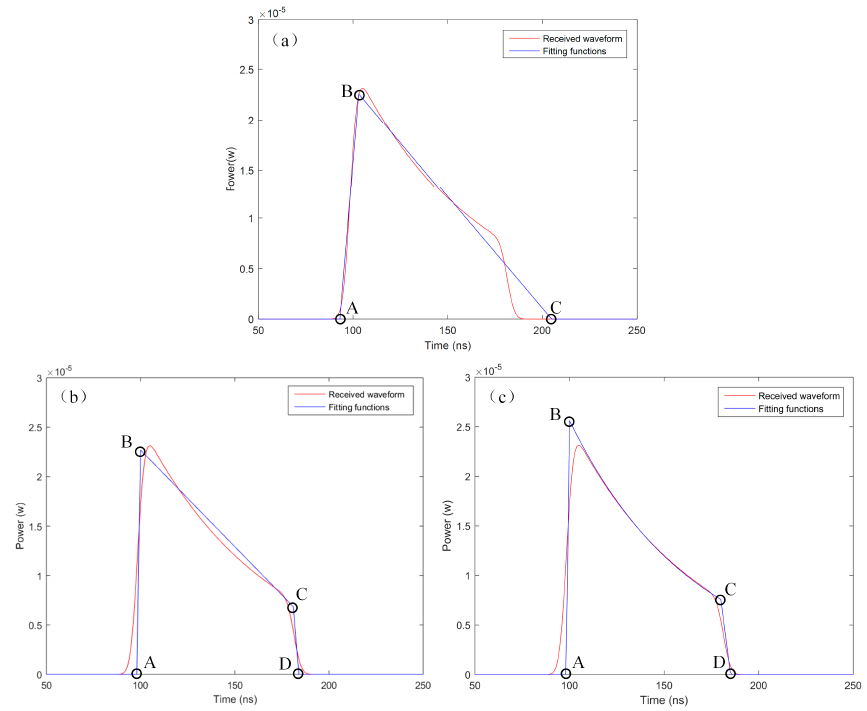
Figure 2. Fitting examples of the column contribution for a simulated waveform without noise, using the airborne sensor parameters: ( a ) triangular fitting function; ( b ) quadrilateral fitting function; and ( c ) improved quadrilateral function.